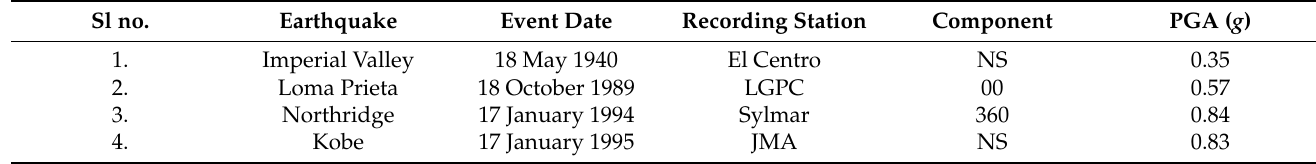
Table 2. General characteristics of the seismic events considered in the current study.